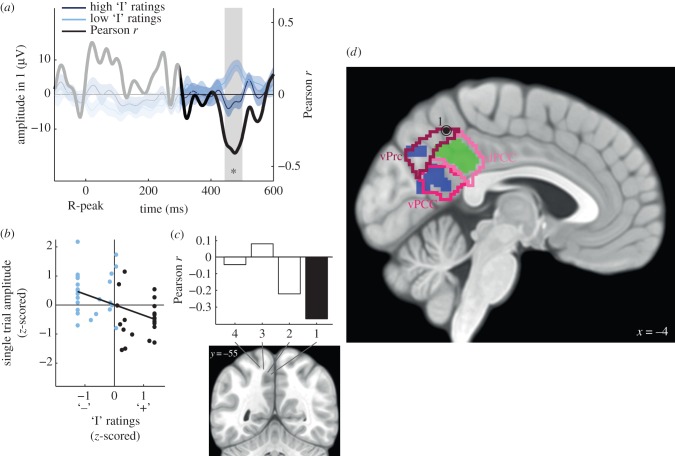
The trial-by-trial amplitude of HERs in the ventral precuneus and vPCC correlates with the involvement of the ‘I’ in spontaneous thoughts (patient 4). (a) Time course of the Pearson correlation coefficient r between the trial-by-trial HER amplitude and the ratings on the ‘I’ scale (black), and HERs (±s.e.m.) for ‘high’ (dark blue) and ‘low’ (light blue) ratings on the ‘I’ scale (median split of ratings), for recording site 1. The signal that might be residually contaminated by the cardiac-field artefact appears in lighter colour (not included in the analysis). The grey area highlights the time window in which a significant trial-by-trial correlation between HER amplitude and ‘I’ ratings was observed. (b) HER amplitude in the significant time window plotted against ‘I’ rating. Each point represents one trial. (c) Mean Pearson correlation coefficient in the 444–500 ms time window, along the different recording sites of the electrode shaft. The black bar corresponds to the recording site for which a significant correlation was found. (d) Differential HERs, parasympathetic regulation and posteromedial cortex. The circled dot indicates the location of recording site 1. Regions in blue showed differential responses to heartbeats along the ‘I’ scale, in a previous MEG study [25]. Regions in green are involved in parasympathetic regulation [34]. Outlines correspond to the parcellation of the posteromedial cortex [32]: ventral precuneus (vPrc, dark pink), dorsal cingulate (dPCC, light pink) and ventral cingulate cortex (vPCC, pink).